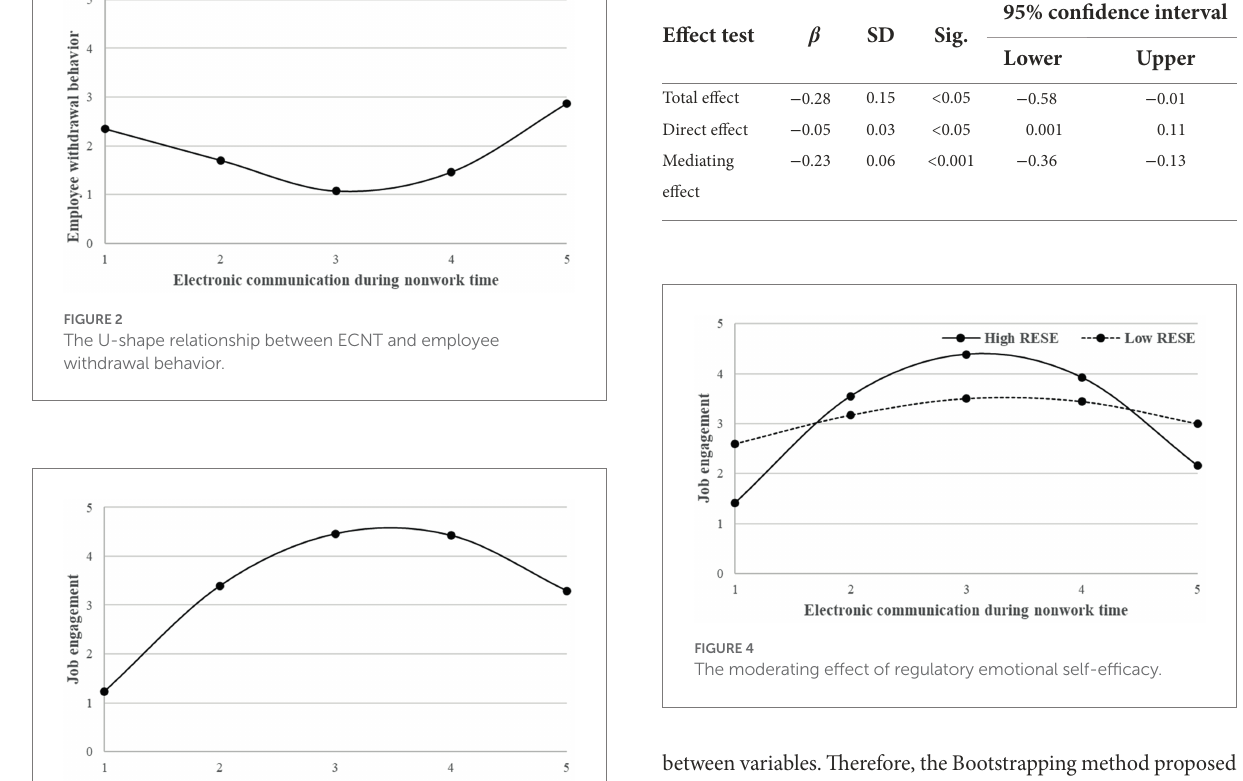
FIGURE 3 The inverted U-shape relationship between ECNT and job